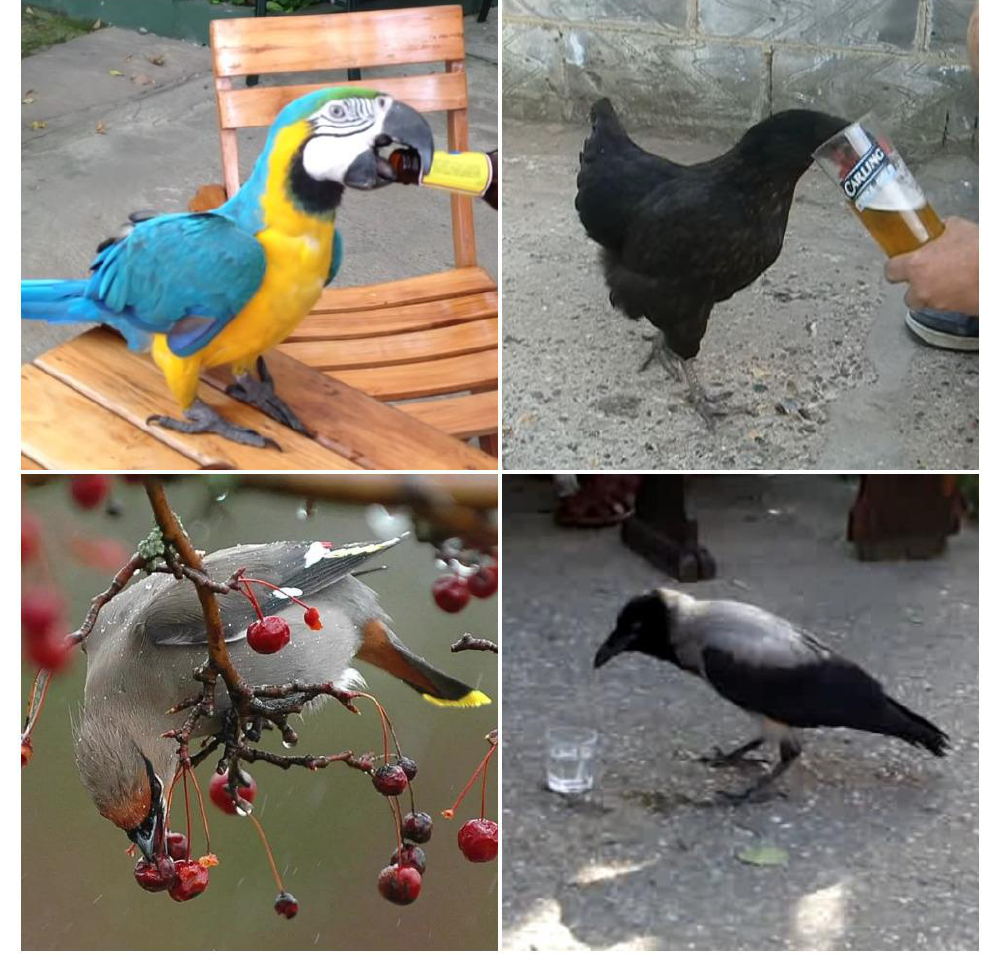
Figure 2. Examples from YouTube of birds drinking alcoholic beverages: ( a ) blue-and-yellow macaw Ara ararauna drinking beer in a pub in Columbia, https://youtu.be/nXZSVfT7UwI; ( b ) hen Gallus gallus drinking beer, https://youtu.be/ubqHeIiyVf4; ( c ) Bohemian waxwing Bombycilla garrulus eating ripe berries and subsequently having problems with flight, Canada, https://youtu.be/d_NqGjV3l_8; ( d ) hooded crow Corvus cornix drinking vodka, Hungary, https://youtu.be/xlq6GCekPNA. Table 1. Interactions between birds and alcohol provided in different forms reported in the scientific literature. Sources are arranged from oldest to newest.